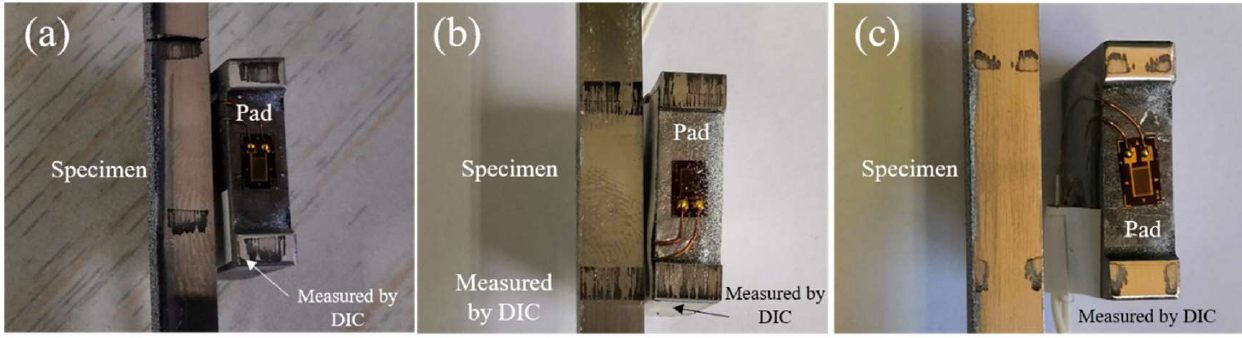
Figure 5. Fretting scar on the specimen and fretting pad for ( a ) F a = 8.5 kN, ( b ) F a = 7.3 kN, and ( c ) F a = 6.5 kN.